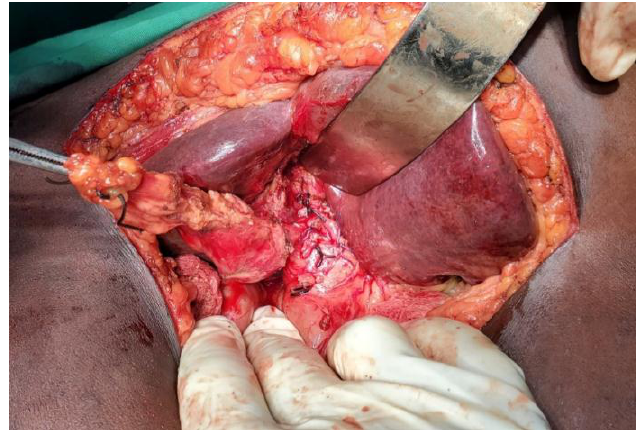
Figure 1: Intra-operative photo of scleroatrophic gallbladder is hanging on its cystic duct and completion of antegrade fundus-first cholecystectomy related to difficult dissection of tense fibrous tissue scars in the Calot’s triangle. This result from long-standing chronic cholecystitis combined with CBD